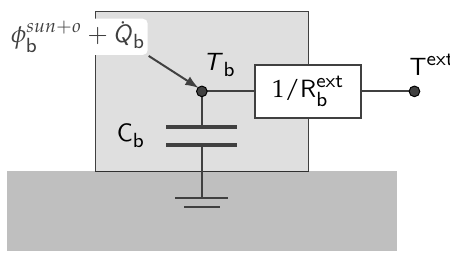
Figure A1. 1R1C building model.